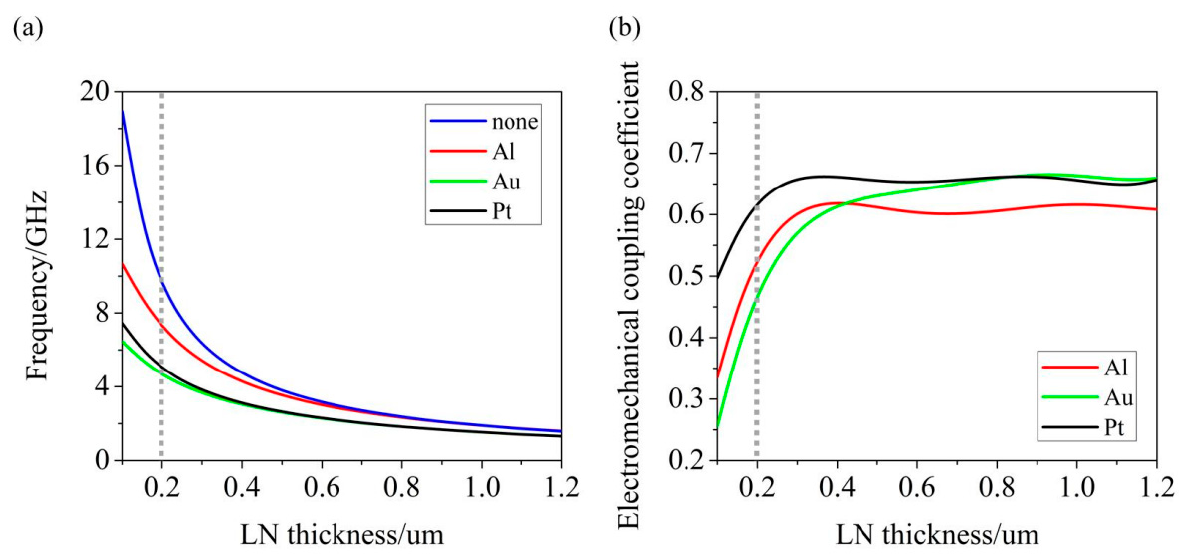
Figure 3. ( a ) Relationship between the thickness of the x-cut LiNbO 3 film and the resonance frequency of the YBAR with different bottom electrode materials. ( b ) Relationship between the thickness of the x-cut LiNbO 3 film and the electromechanical coupling coefficient of the YBAR with different bottom electrode materials.